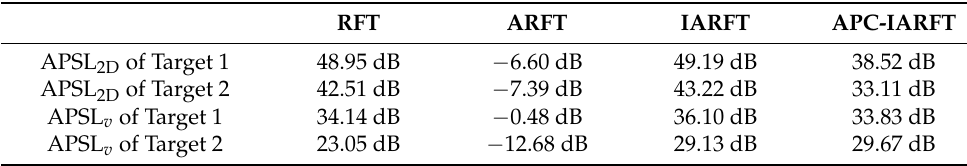
Table 8. APSL 2D and APSL v of the targets set in Scenario